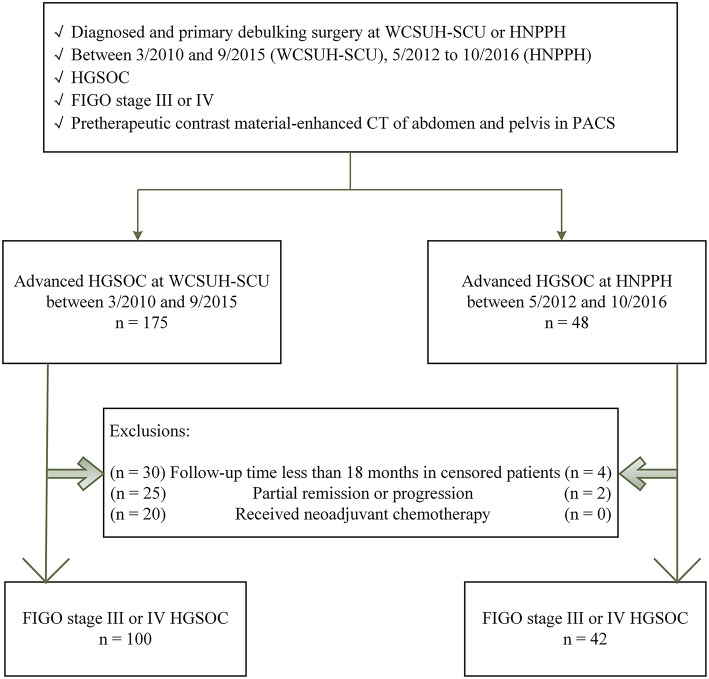
Eligibility criteria. Flowchart depicting the patient selection process. WCSUH-SCU, West China Second University Hospital of Sichuan University; HNPPH, Henan Provincial People's Hospital; HGSOC, High-Grade Serous Ovarian Cancer; FIGO, International Federation of Gynecology and Obstetrics; PACS, Picture Archiving and Communication System.